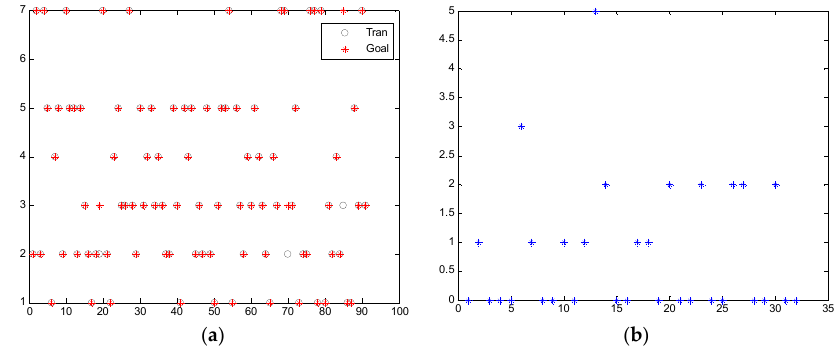
Figure 11. Performance of the designed RBF classification network: ( a ) training performance; ( b ) plot of the detection error.